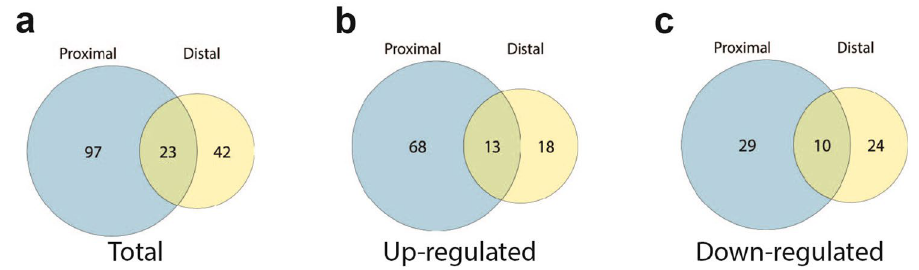
Figure 4. Regional differences in DEGS are observed in proximal and distal achalasia subjects. ( a ) Venn diagram showing overlap of total DEGs in the proximal and distal esophagus of dilated achalasia subjects. ( b ) Venn diagram showing overlap of up-regulated DEGs in the proximal and distal esophagus of achalasia subjects. ( c ) The overlap of down-regulated DEGs between proximal and distal esophagus of achalasia subjects is shown in a Venn